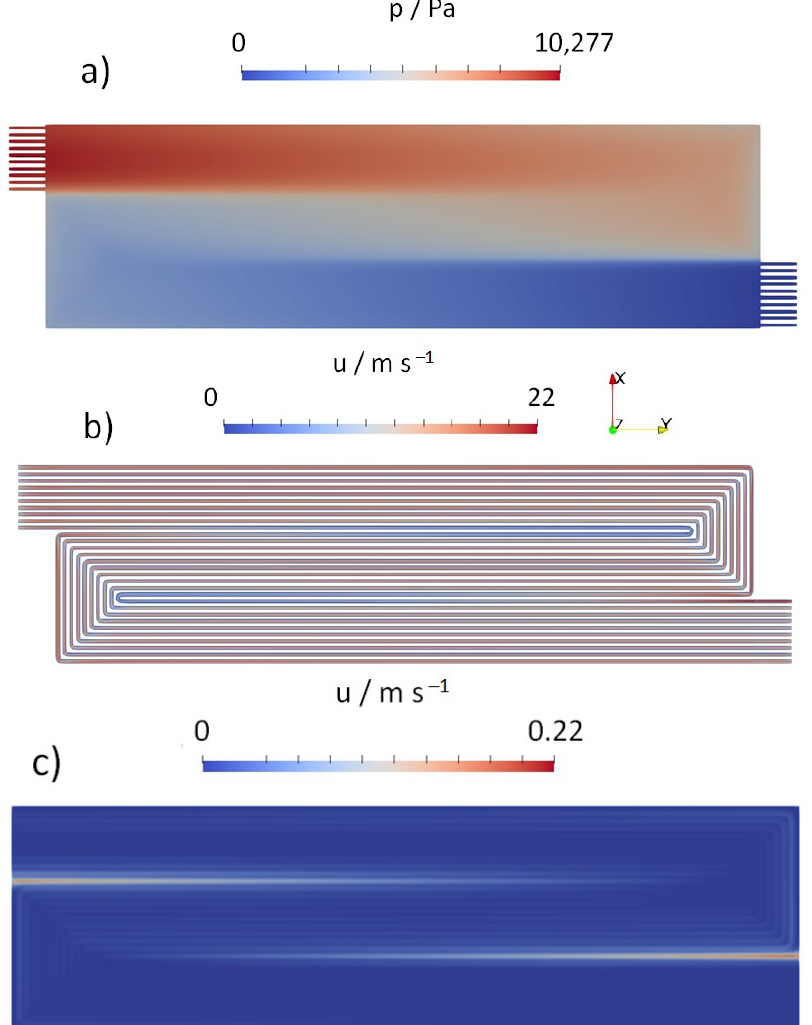
Figure 12. Flow distribution for the cathode plate at 0.44A cm − 2 . ( a ) Pressure distribution; ( b ) velocity (magnitude) at half channel depth; ( c ) velocity (magnitude) at half GDL